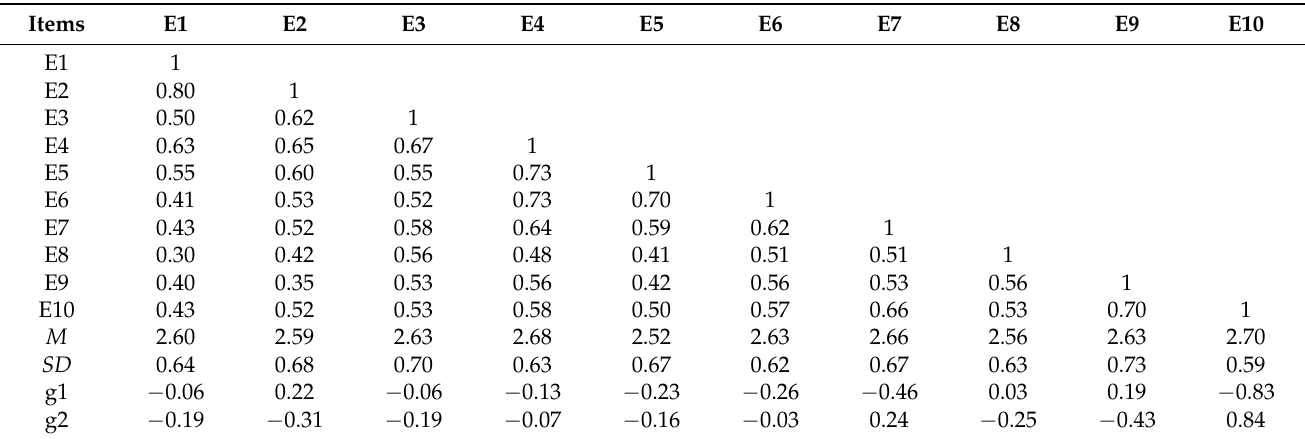
Table 1. Polychoric correlation matrix and descriptive analysis of the